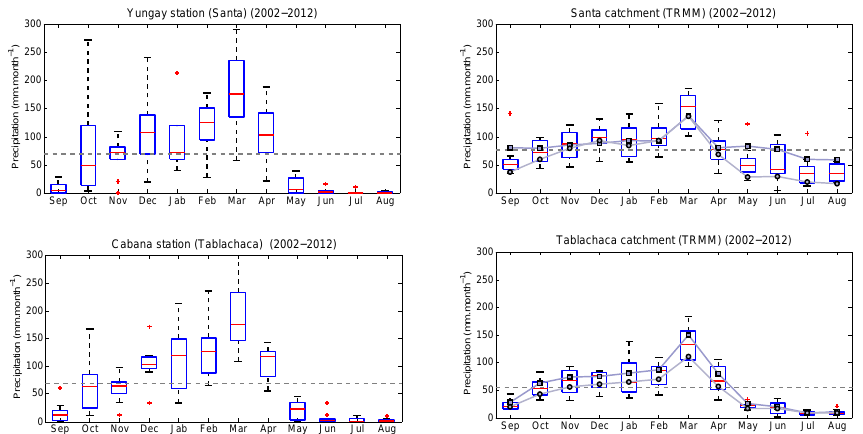
Fig. 4. Boxplots of mean monthly precipitation for 2002–2012 (red lines inside boxes) showing atypical events (“ + ”) and 5th and 95th percentiles (ends of the dotted line). The horizontal dashed line is the monthly mean. On the left, observed precipitation based on daily values at Yungay and Cabana stations, representing Santa and Tablachaca sub-catchments, respectively. On the right, monthly TRMM (3B43 7V) catchment precipitation in each 0.25 ◦ × 0.25 ◦ grid. To capture spatial variability, filled squares were calculated from TRMM pixels above 3800ma.s.l., while filled circles were calculated from TRMM stations below